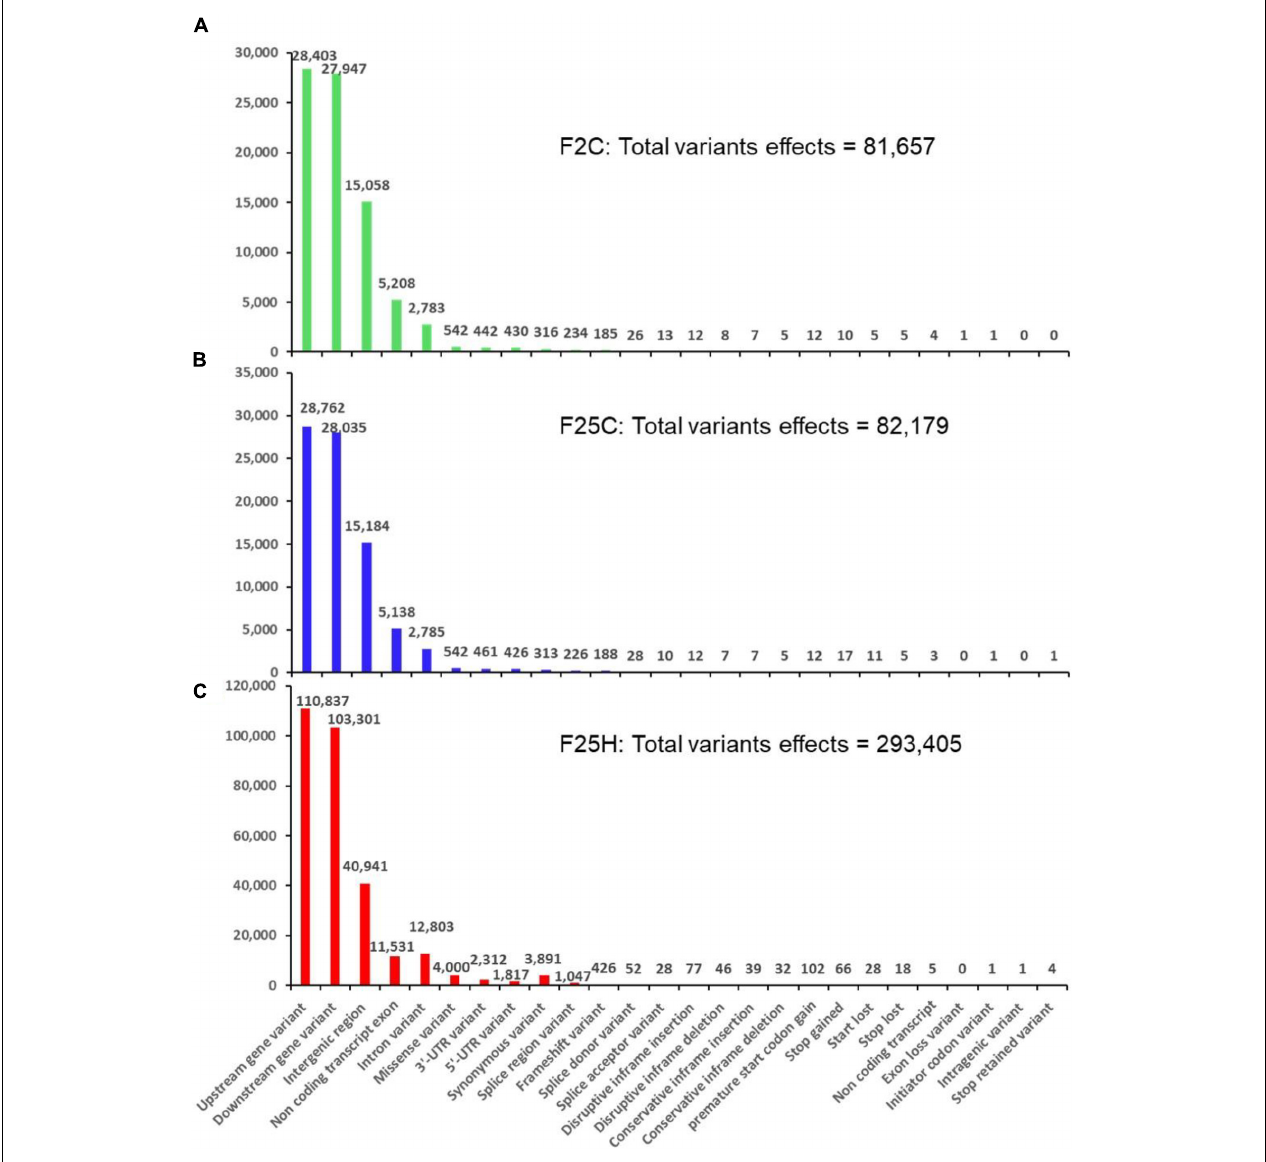
FIGURE 3 | The distribution of variants across the genome by their potential effects based on genomic positions (with relaxed parameters). (A) F25H, (B) F25C, and (C) F2C. The number of variant effects is shown above each bar, and genomic positions effects from SnpEff are listed on the x -axis.